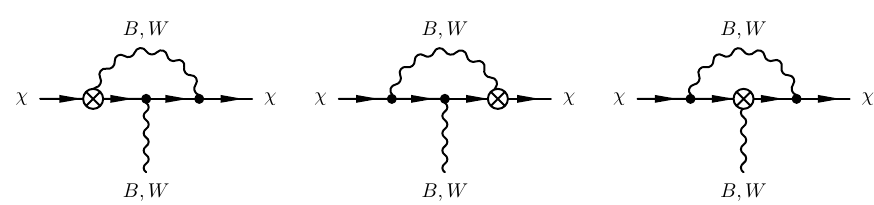
; Q 0 (5) operators due to B (cid:22) ; W a 1 2